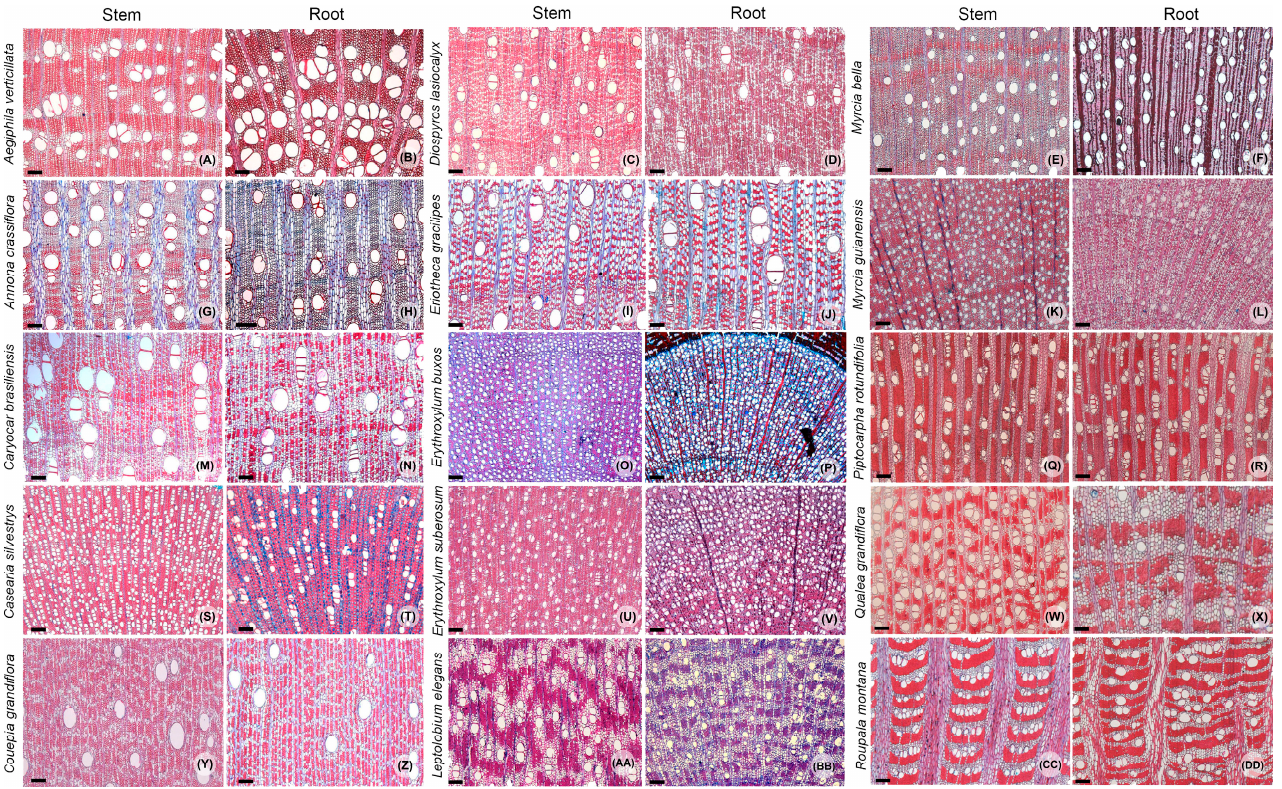
Figure 1. Stem and root wood, in the transversal section, of studied Cerrado Brazilian plants. For leaf habit type, see Table 1. Scale bars= 200 μ m. Table 1. Characteristics of studied species. Values represent means ± standard error (N = 3). Stem and root diameters were measured at 60 cm aboveground and 15–30 cm belowground, respectively. Dec: deciduous; Sd: semi-deciduous; Ev: evergreen.